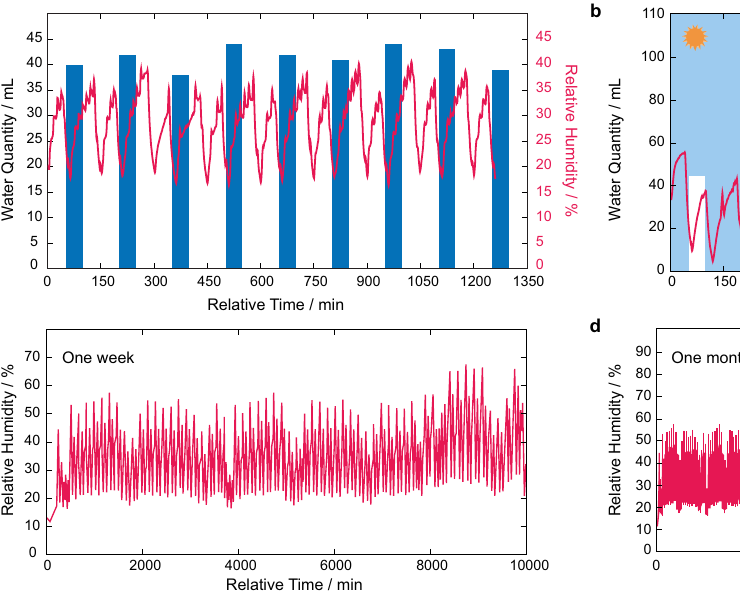
Fig.5|Adaptivewaterharvestingstresstestsforaday,week,andmonthinreal desert, arid environments. a Stress test for 24h performed under a controlled environment (20% RH and 25°C). The adaptive device is consistent in water pro- duction without loss in performance. b Real-environment performance evaluation for one full day demonstrating adaptive performance as a function of day-night fl uctuations in environmental conditions. c Real-environment continuous